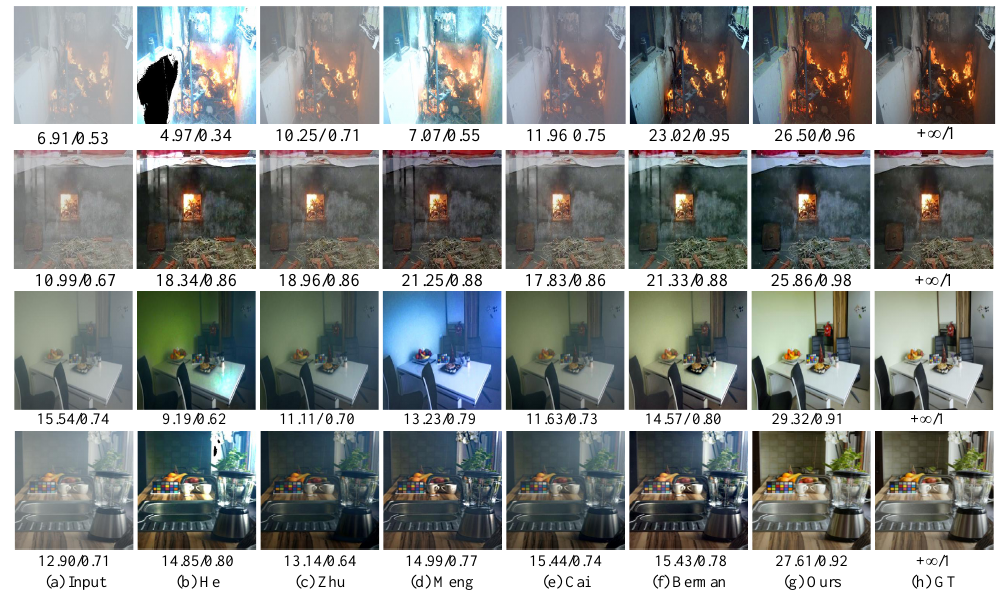
Figure 5. The performances of different image dehazing algorithms on synthetic indoor